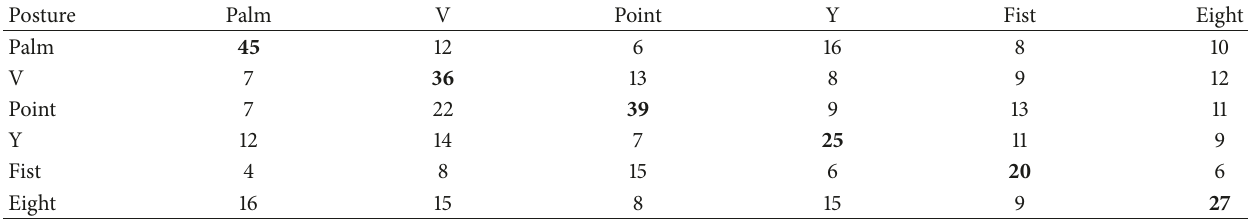
Table 6: The number of matching points between different posture classes.